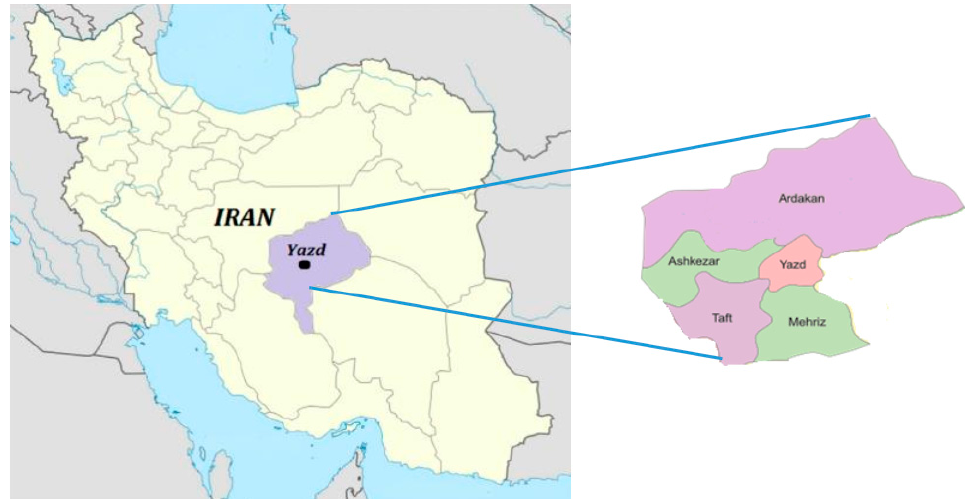
Figure 1. Map of sampling locations for birds in Yazd province in central Iran during 2018 and 2019.